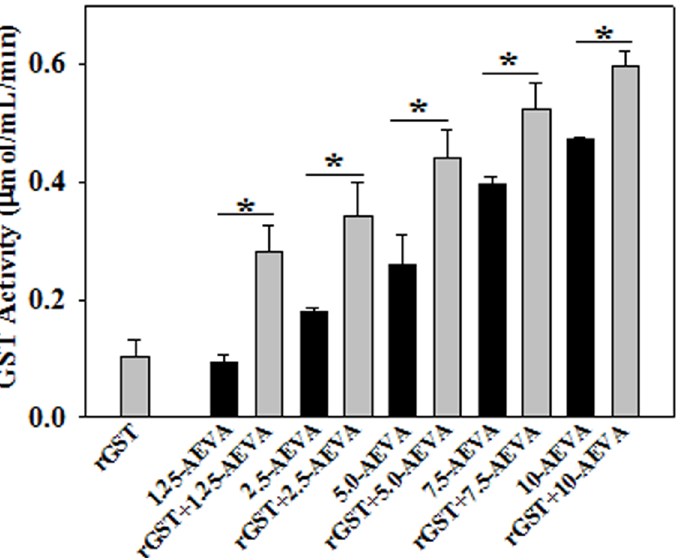
Fig 8. Dose dependent effect of AEVA on GST activity using recombinant GST (rGST). 100 μ L of rGST (36 μ g/mL) was incubated with different concentration of AEVA (1.25, 2.50, 5.00, 7.50, and 10.00 μ g μ L -1 ) for 2 h at 37°C. “ * ” indicates the significant difference between “ AEVA alone ” and “ rGST+ AEVA ” at the respective concentration of AEVA ( p * < 0.05). Values are mean ± SE (n = 4).